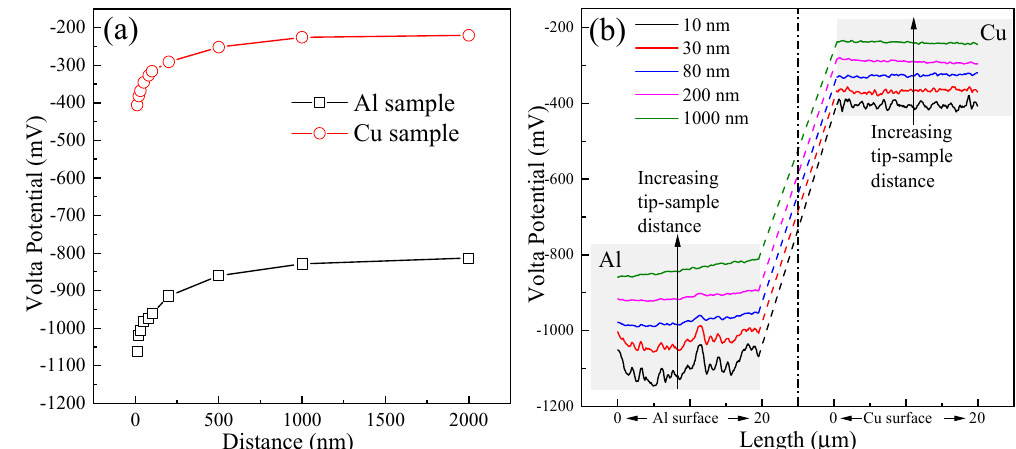
Figure 1. Effect of probe-sample distance on the Volta potential: ( a ) Volta potential is measured at different distances between the tip and Al (top) or Cu (bottom), ( b ) the continuous change in the Volta potential on the surface of Al or Cu at different distances from the samples to the tip.